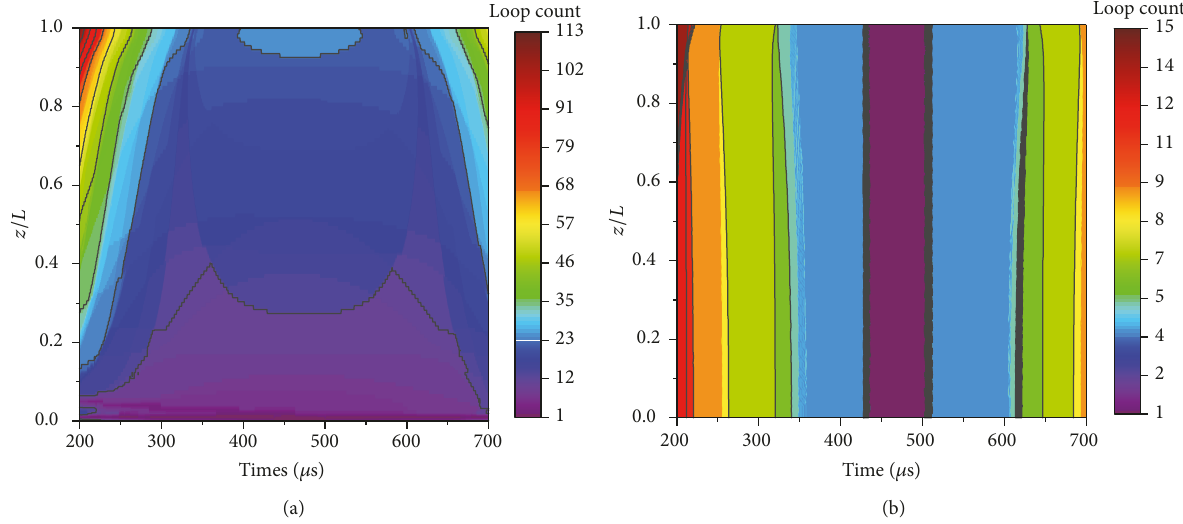
Figure 6: Spatial-temporal distribution of the loop count of procedures (i)–(vi) with (a) “Initial-S” and 𝛿 = 0.7 × 10 −4 . (b) “Initial-T” and 𝛿 = 0.54 × 10 −4 .